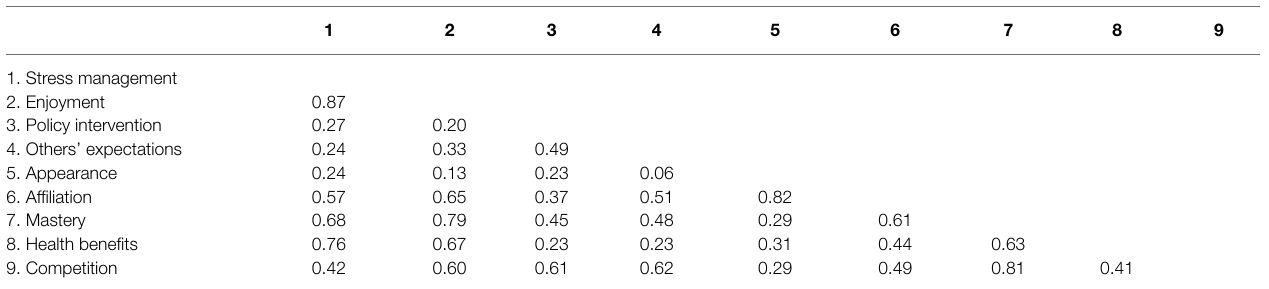
TABLE 7 | Heterotrait-monotrait ratio (HTMT) of nine-factor model in CUSPAMS analysis. 1